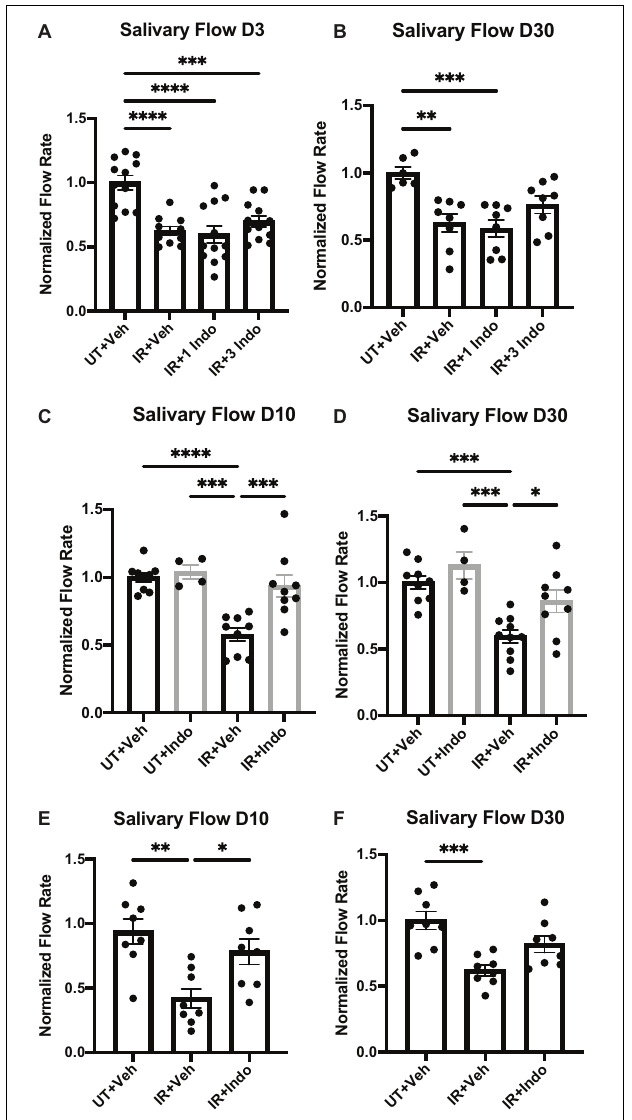
FIGURE 1 | Pre- versus post-radiotherapy indomethacin treatment differentially modulates salivary flow rates in mice. (A–D) FVB or (E,F) C57BL/6J mice were untreated (UT) or treated with 5 Gy ionizing radiation (IR) and intraperitoneal injections of vehicle (Veh, saline with 10% ethanol) or indomethacin (Indo, 1 mg/kg body weight) (A,B) 1 h prior to radiation (1 Indo) or again at days 1 and 2 post-IR (3 Indo) or (C–F) at days 3, 5 and 7 post-IR.